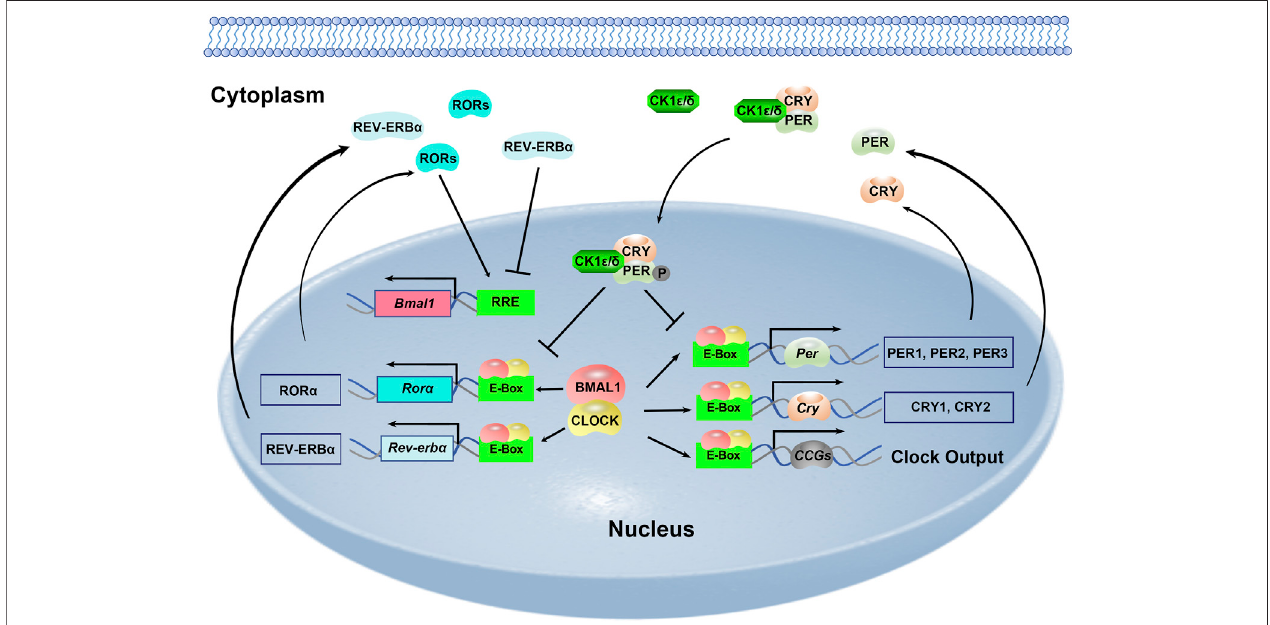
FIGURE 1 | Molecular framework of the mammalian circadian